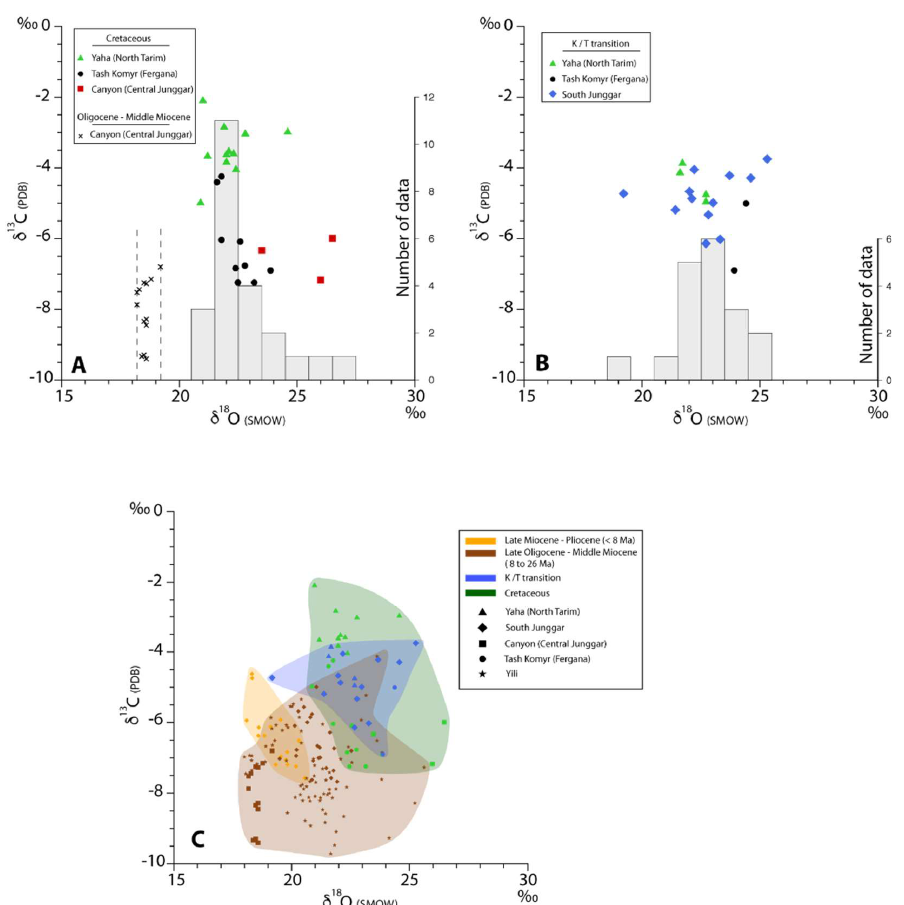
Figure 6. ( A ) Oxygen versus carbon isotope composition of the Cretaceous and Quaternary samples from the three studied sections. The histogram represents the frequency distribution of δ 18 O values for the Cretaceous samples. ( B ) Oxygen versus carbon isotope composition of the Cretaceous–Paleogene transition samples from the Yaha and Tash Komyr sections (this study), as well as from the South Junggar [16]. The histogram represents the frequency distribution of the δ 18 O values. ( C ) Oxygen versus carbon isotope composition of calcareous paleosols (caliche, calcrete and carbonated nodules) from this study and from the literature [15–17]. The color-shaded areas correspond to sample age